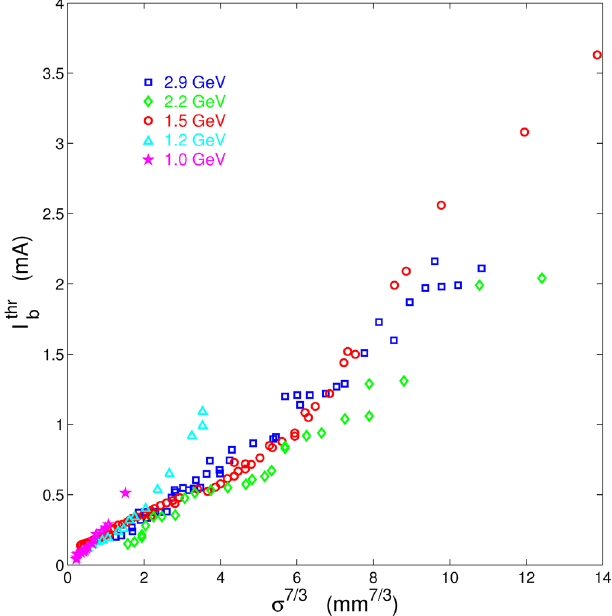
FIG. 11. Experimental threshold bunch current at all five energies plotted as a function of zero-current bunch length raised to the 7 = 3 power. A linear description is expected if the threshold parameter ξ is a universal constant across all modes, which thr Fig. 10 shows is not a rigorous assumption. The synchrotron frequency, which is common to both parameters, varies from point to